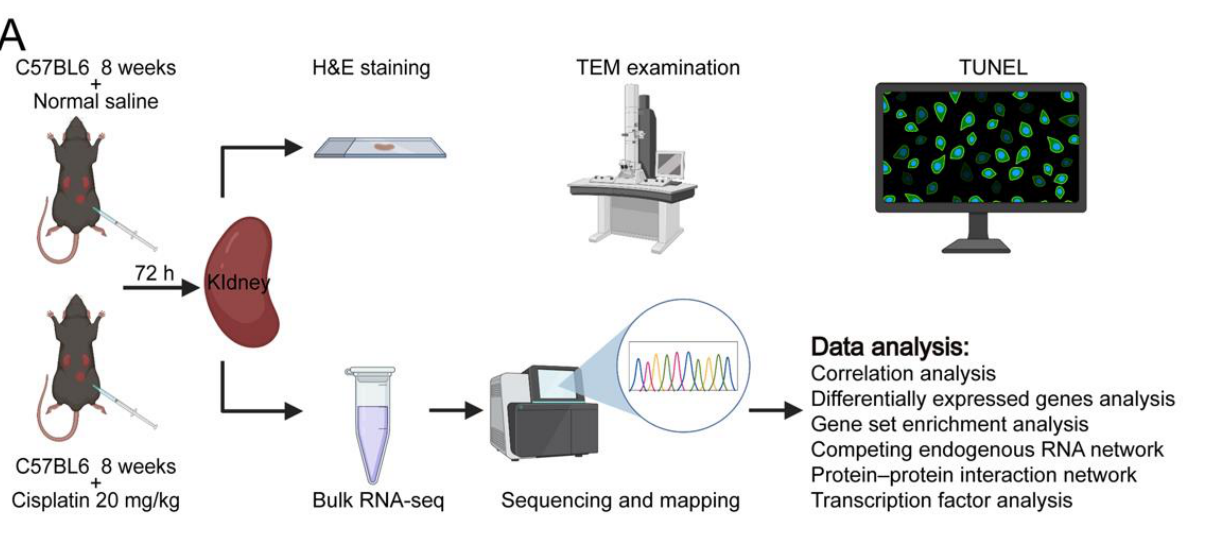
Figure 1. Cisplatin-induced acute kidney injury (CP-AKI) mouse model. ( A ) Experimental design workflow. ( B ) Representative photomicrographs of tubular cell injuries in mouse kidney tissues (hematoxylin and eosin (H&E) staining; original magnification, 200×) and representative photomi- crographs of mitochondrial ultrastructural changes in renal tubular epithelial cells (original magni- fication, 5000×). ( C ) Quantitative analysis of histologic scoring ( n = 5 in each group). ( D ) Immuno- fluorescent labeling for terminal deoxynucleotidyl transferase dUTP nick-end labeling (TUNEL) in mouse kidney tissue sections of the two groups (original magnification, 200×). Apoptotic cells in mouse kidney tissues were evaluated using TUNEL staining (green). Nuclei were stained with 4′,6 - diamidino-2-phenylindole (DAPI) (blue). ( E ) Quantitative analysis of TUNEL-positive cells ( n = 4 in each group). Over 200 cells in each group were evaluated to determine the percentage of TUNEL- positive cells. **** p < 0.0001. 2.2. Blood Biomarker Assay The serum was separated by centrifugation at 3000× g for 10 min at 4 °C. The sCr and blood urea nitrogen (BUN) levels in the CP-AKI and control groups were measured by using creatinine (sarcosine oxidase) and urea assay kits (Nanjing Jiancheng Bioengineer- ing Institute, Nanjing, China).